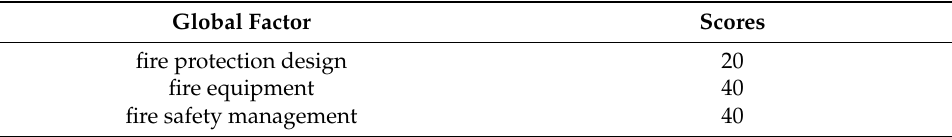
Table 2. The score ratio of each global factor for the fire risk index. Global Factor